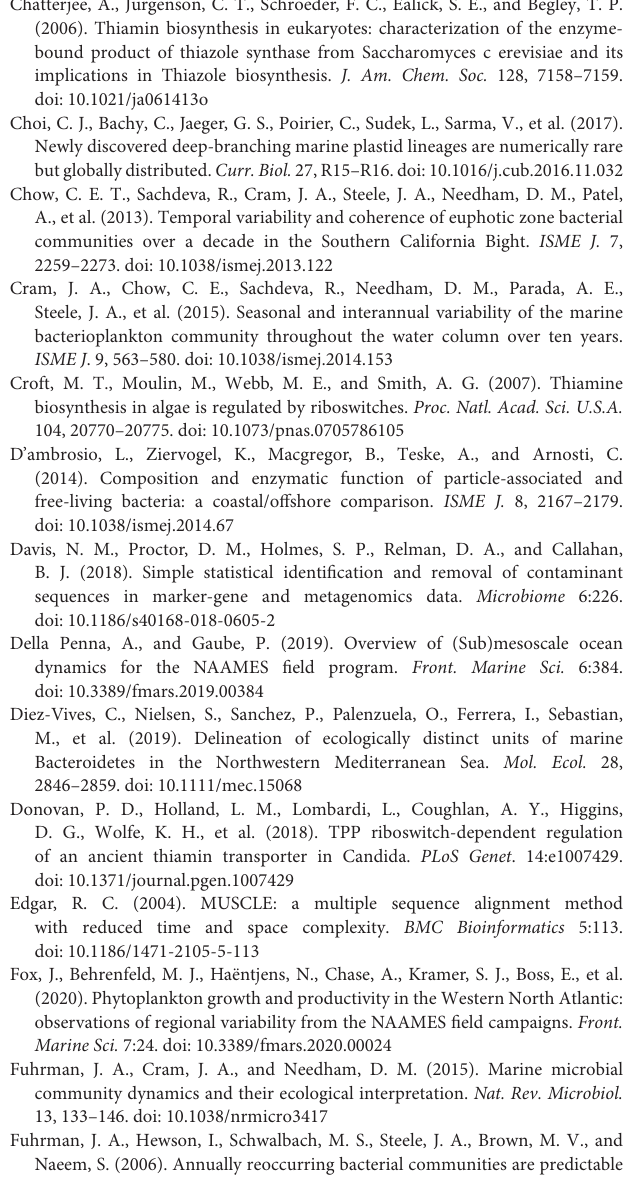
phylogenetic tree was calculated using MAFFT software tool, Method